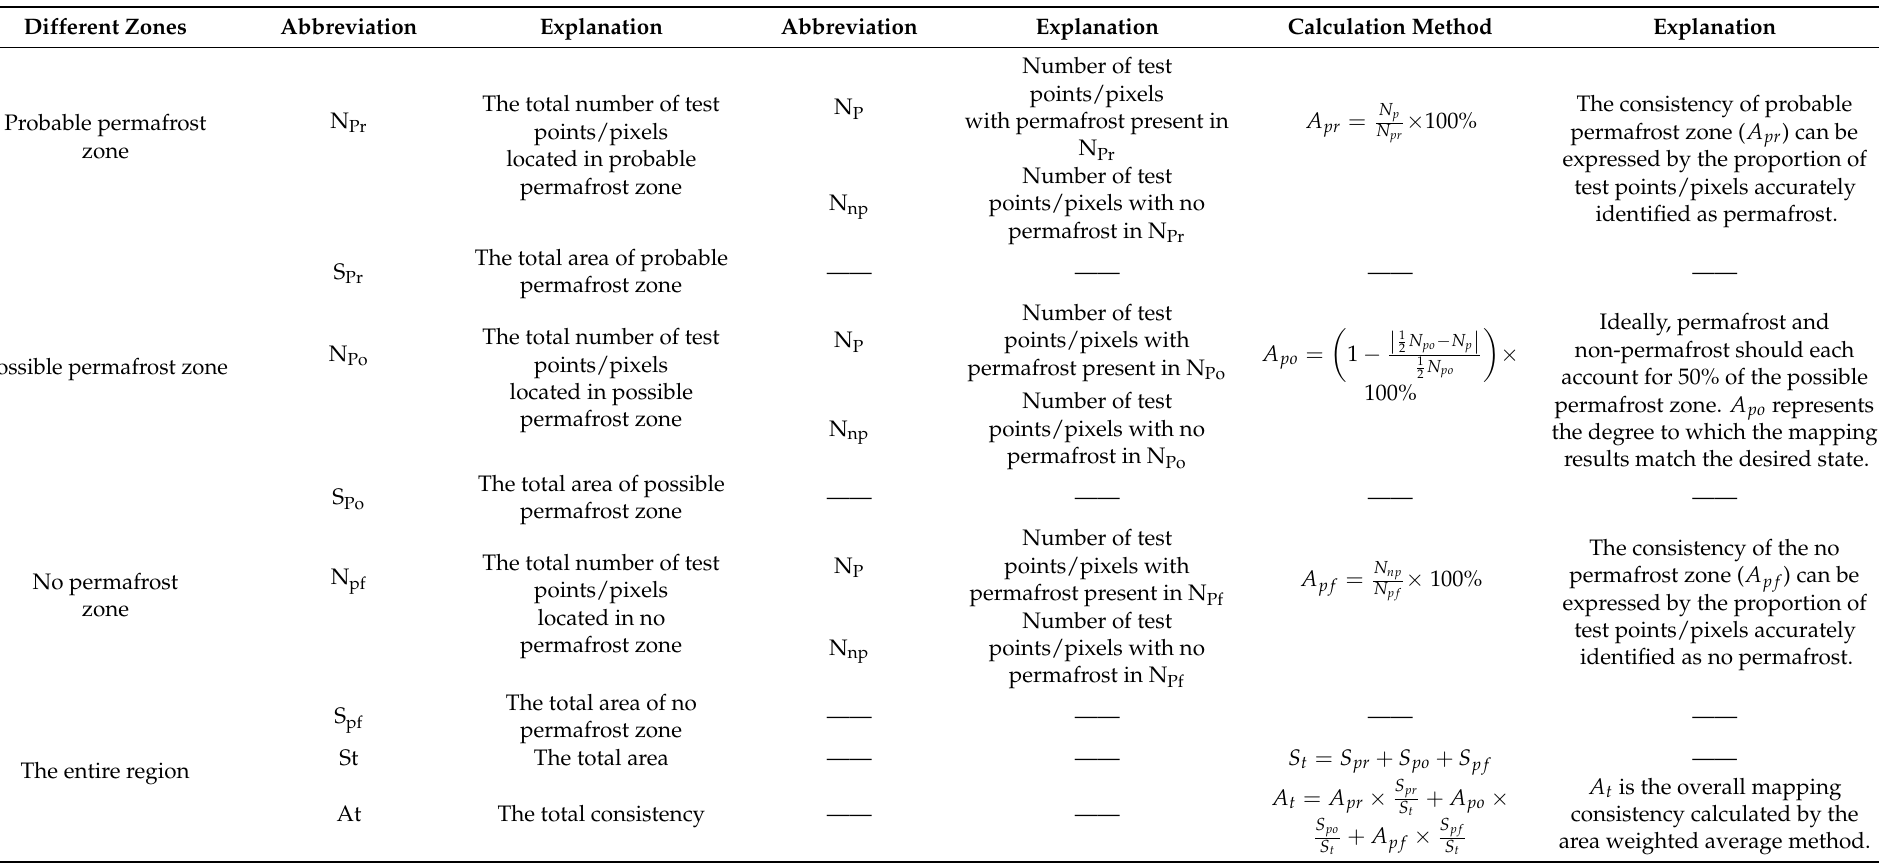
Table 1. The comparison scheme of evaluating consistency between our ternary mapping results and the existing binary maps/field survey